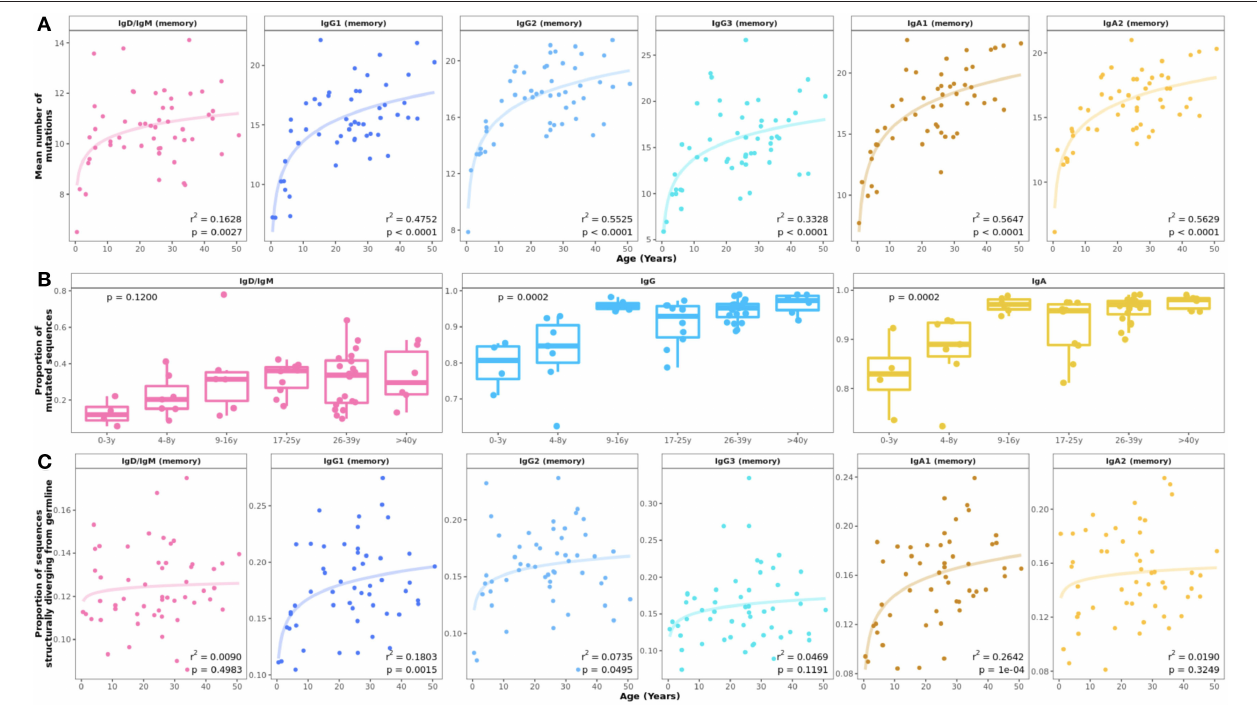
FIGURE 2 | Age-related changes in somatic hypermutation and predicted antibody structure. (A) Mean number of V gene mutations by individual and B cell subset with fitted logarithmic curves. Somatic hypermutation increased mainly in the first 10 years of life with some differences between cell subsets. (B) The proportion of memory IgD/IgM out of all IgD/IgM transcripts and the proportion of mutated IgG and IgA transcripts within repertoires showed significant increases in the first 10 years of life. Statistical differences between groups were tested using the Kruskal–Wallis test. (C) The proportion of sequences structurally different from germline increased in early childhood in all B cell